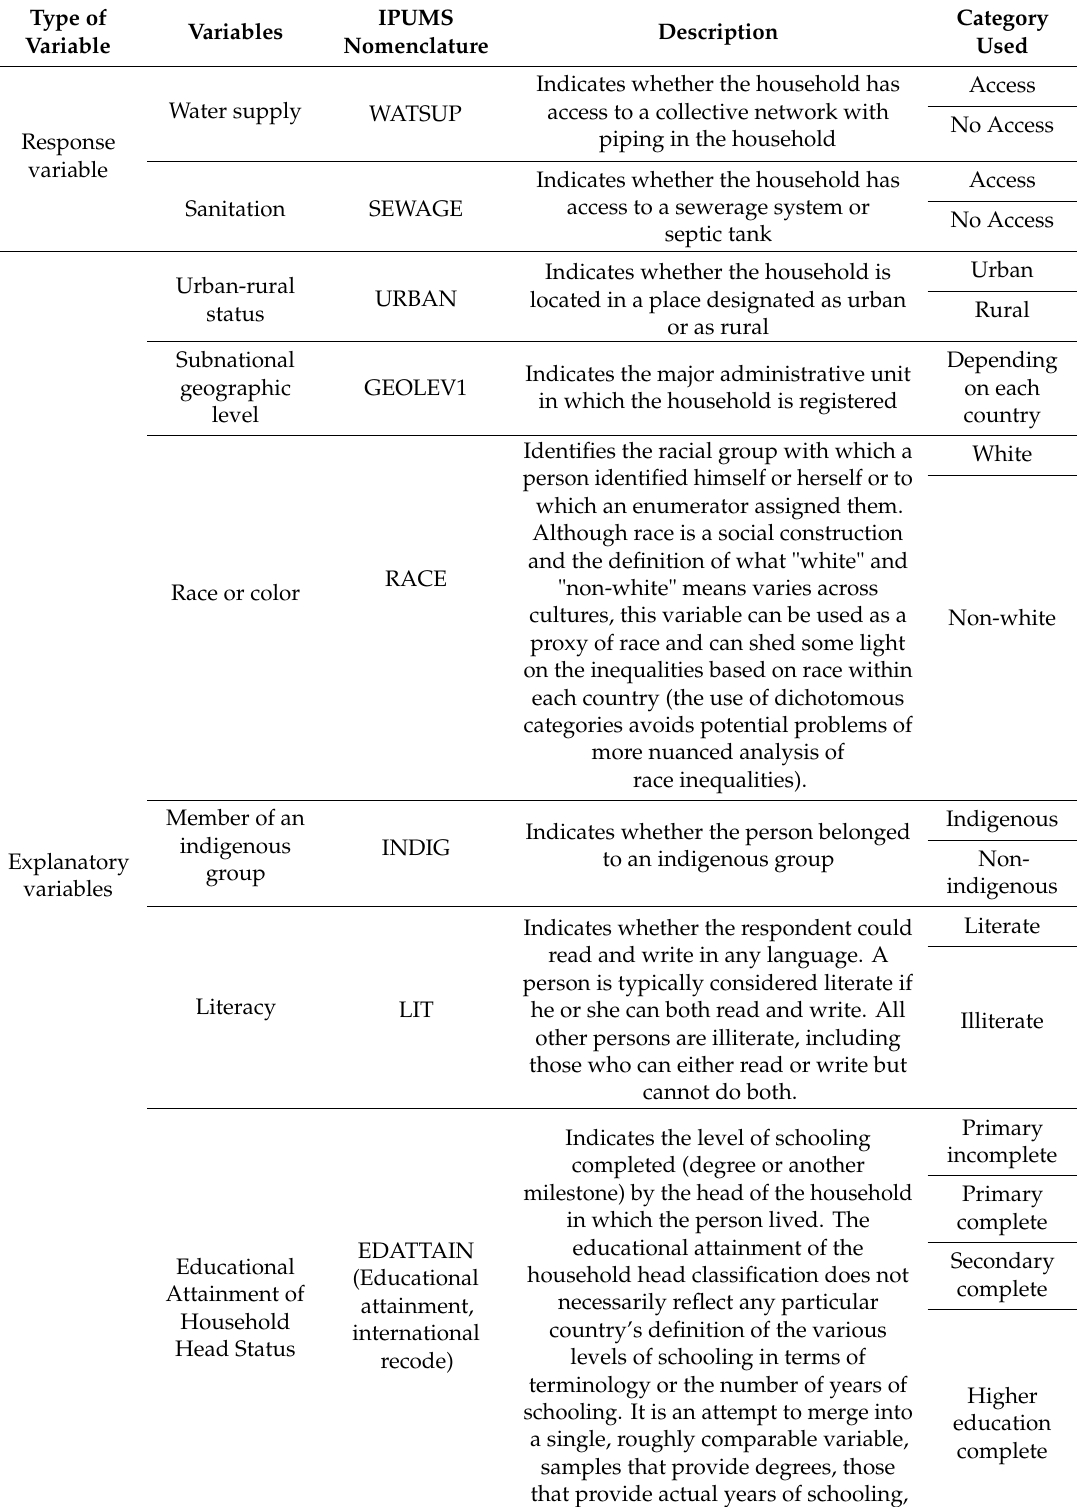
Table 1. Variables and nomenclatures used for